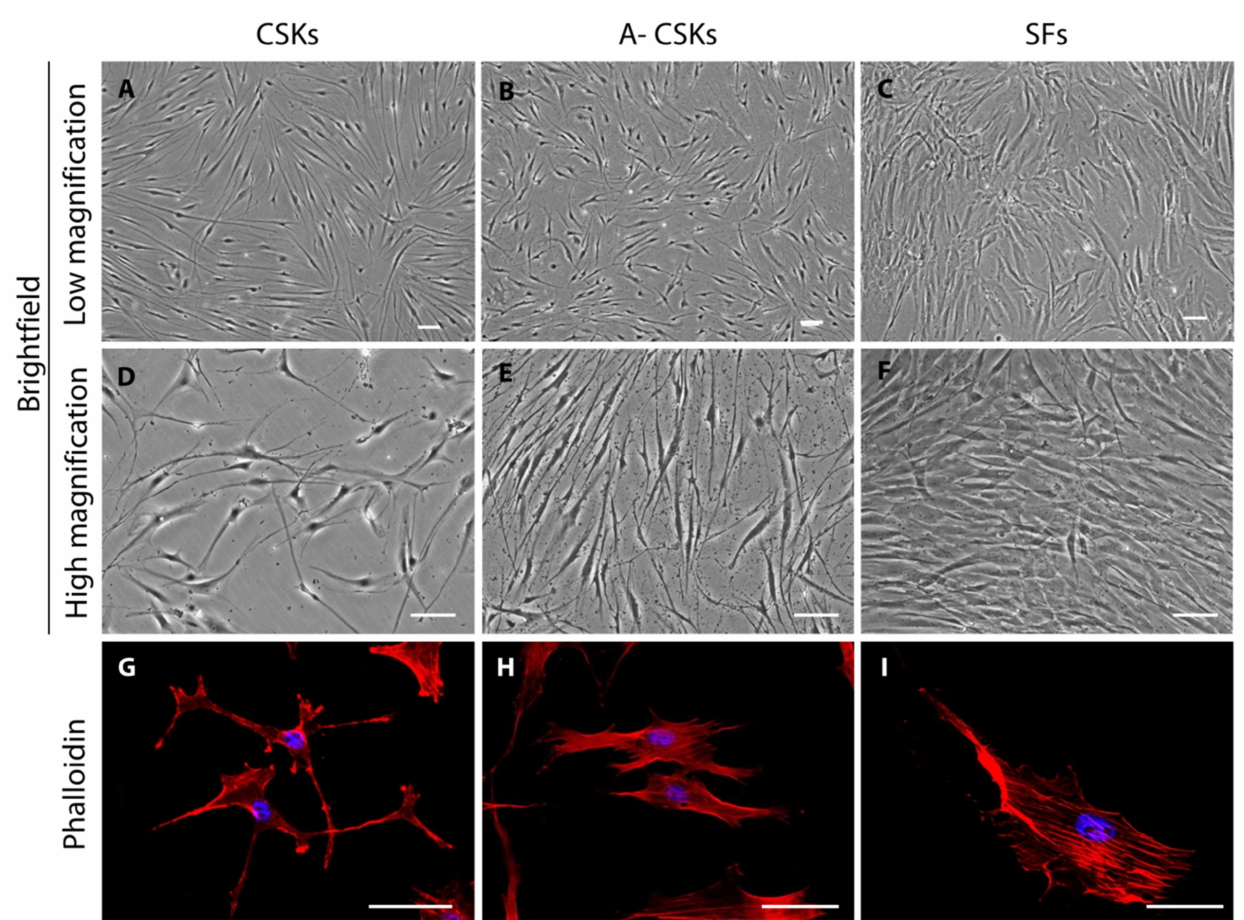
Figure 4. Morphology of corneal stromal keratocytes (CSKs), activated CSKs (A-CSKs), and stromal fibroblasts (SFs). The representative images were captured from cells at P5, which were expanded from the same donor. ( A – F ) Brightfield images at low and high magnification revealed the loss of thin, dendritic morphology and long cellular processes, typically seen in the CSKs, in the SFs. The SFs also featured larger cell bodies compared to the CSKs and A-CSKs. ( G – I ) Phalloidin staining showed the stellate morphology of the CSKs, which was progressively lost in the A-CSK and SF cell culture. Scale bars = 100 µ